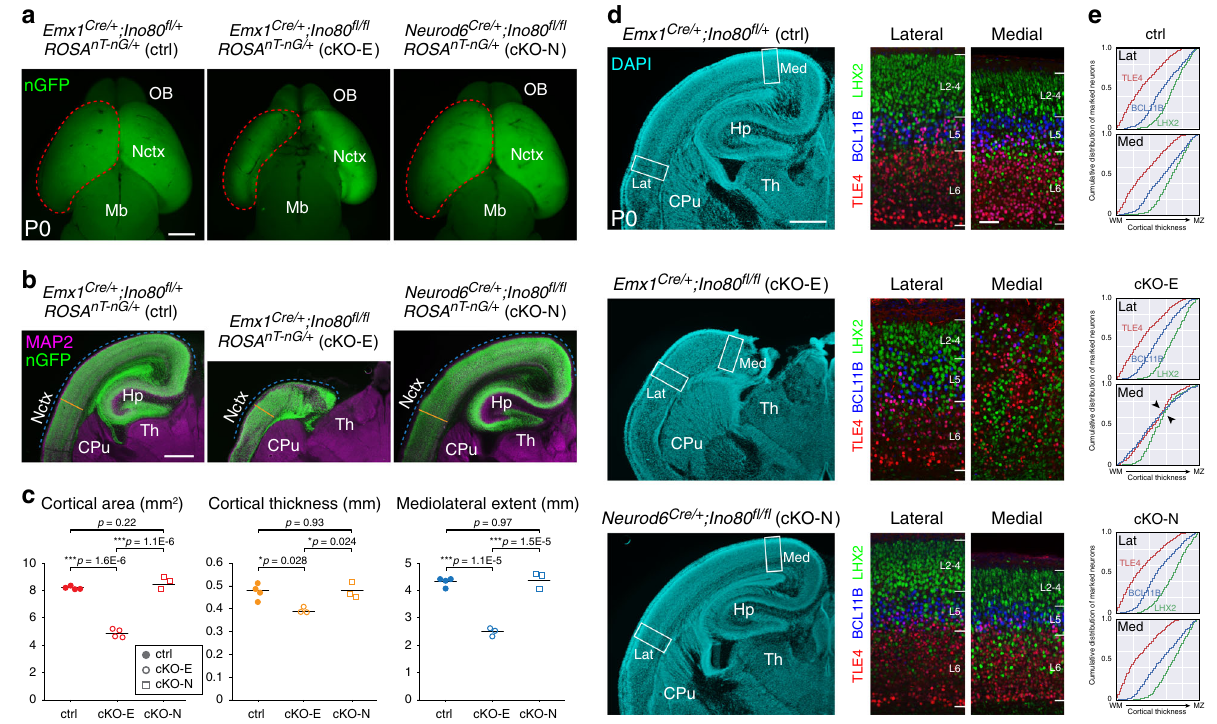
Fig. 1 Microcephaly and disrupted medial corticogenesis following Ino80 deletion from NPCs. a Dorsal view of whole-mount P0 control (ctrl) and Ino80 conditional mutant (cKO) brains. Nuclear (n)GFP (green) was expressed Cre-dependently from ROSA nT-nG . Emx1 Cre -mediated Ino80 deletion from cortical NPCs (cKO-E) led to microcephaly, whereas Neurod6 Cre -mediated Ino80 deletion from postmitotic excitatory neurons (cKO-N) did not. Sample measurements of cortical area (red) quanti fi ed in c are indicated (ctrl: n = 4, cKO-E: n = 4, cKO-N: n = 3 animals). OB olfactory bulb, Nctx neocortex, Mb midbrain. b MAP2 (magenta) and nGFP (green) immunostaining of coronal P0 brain sections. cKO-E, but not cKO-N, was characterized by microcephaly and severe hippocampal hypoplasia. Sample measurements of cortical thickness (yellow) and mediolateral extent (blue) quanti fi ed in c are indicated (ctrl: n = 4, cKO-E: n = 3, cKO-N: n = 3 animals). CPu caudate putamen, Hp hippocampus, Th thalamus. c Cortical area (red), thickness (yellow), and mediolateral extent (blue) were each signi fi cantly decreased in cKO-E, but not cKO-N, compared with ctrl (data are mean, one-way ANOVA with Tukey ’ s post hoc test, Cortical area, ctrl: n = 4, cKO-E: n = 4, cKO-N: n = 3 animals, thickness and mediolateral extent, ctrl: n = 4, cKO-E: n = 3, cKO-N: n = 3 animals). d DAPI staining (cyan) of coronal P0 sections revealed altered lamination of medial neocortex and severe hypoplasia of hippocampus in cKO-E ( n = 3 animals). Analyzed by marker immunostaining (insets), the lamination of LHX2 + (L2-5, green), BCL11B + (L5, blue), and TLE4 + (L6, red) neurons was correctly ordered in lateral (Lat) neocortex of cKO-E, but severely disrupted in medial (Med) neocortex. In cKO-N, normal lamination was present in medial and lateral neocortex. e , Analysis of cumulative distribution of layer marker-expressing neurons through thickness of cortex from white